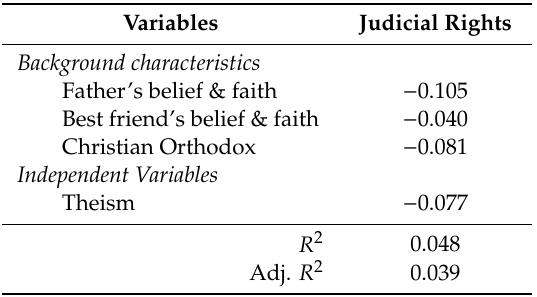
Table 12. Regression analysis for judicial rights with weights ( β ) for each variable and total explained variance ( R 2 and adjusted R 2